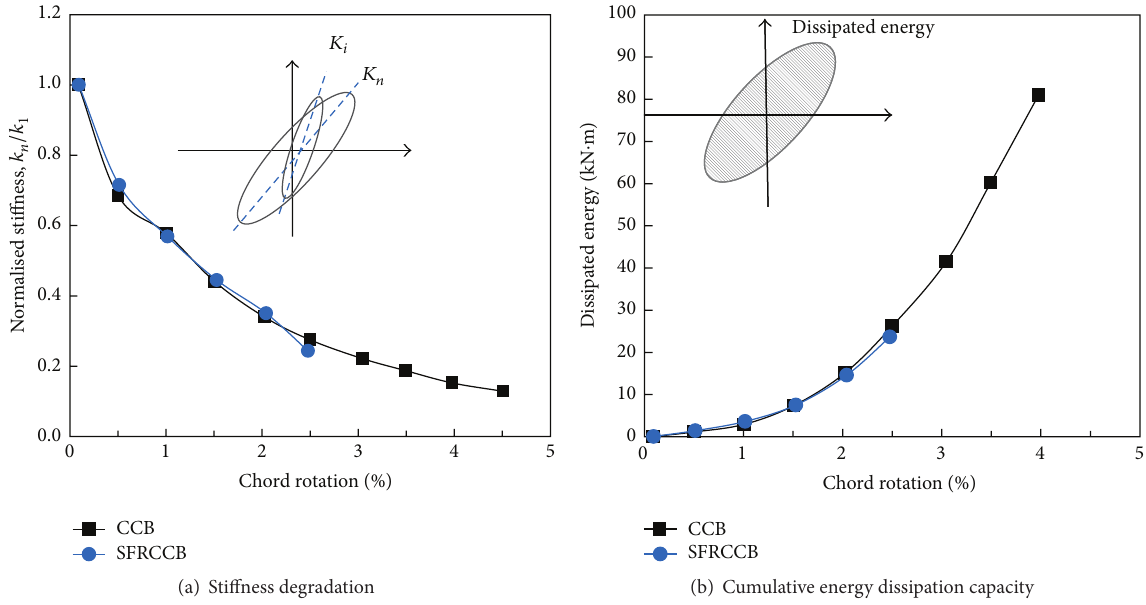
Figure 9: Stiffness retention and energy dissipation